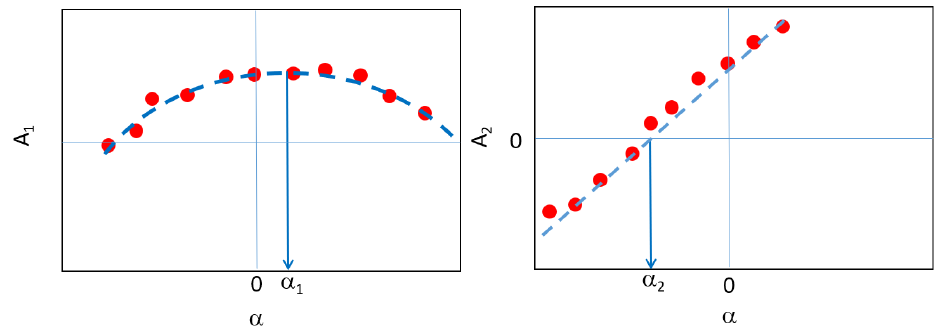
Figure 11. Representation of the effective area dependence with the rotation angle α for the two directions of measurements ( φ , θ ): the affective area and the angle of misalignment α 0 are identified from best-fit of measurements.